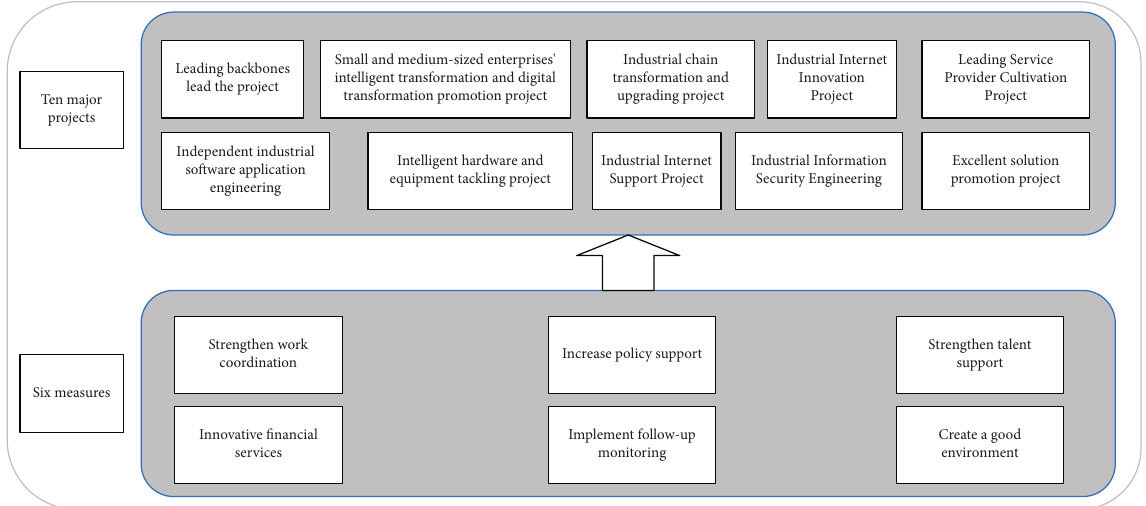
Figure 3: Jiangsu “intelligent change digital transformation”